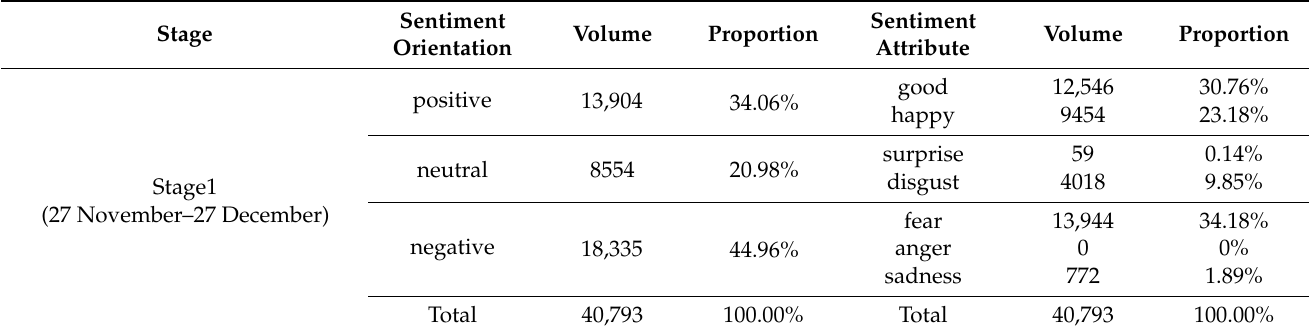
Table 3. Results of sentiment orientation and attribute